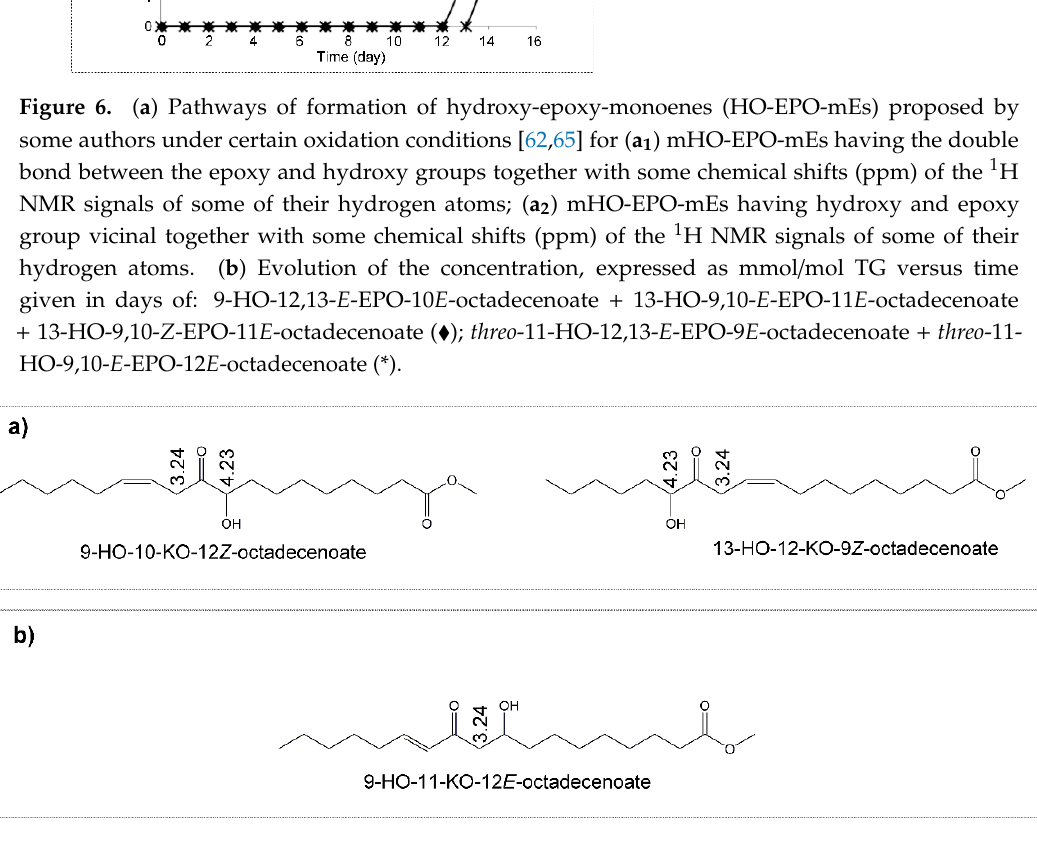
Figure 7. Chemical structures of the hydroxy-keto-monoenes (HO-KO-mEs) involved in this study, together with some chemical shifts (ppm) of the 1 H NMR signals of some of their hydrogen atoms. ( a ) Structures in which keto group and the hydroxy group are on vicinal carbon atoms; ( b ) structure in which the hydroxy group is in beta position regarding the keto group.